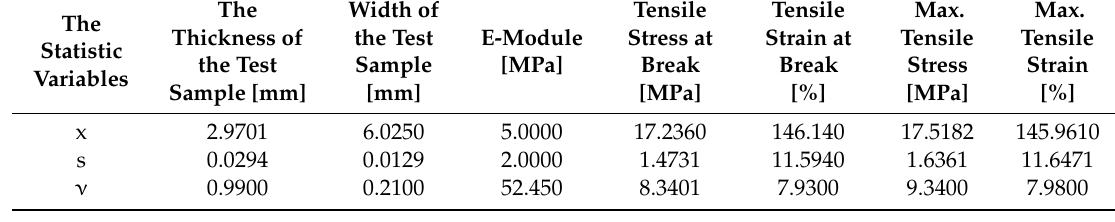
Table 5. Tensile test results according to DIN EN ISO 527 before exposure to laboratory light sources.